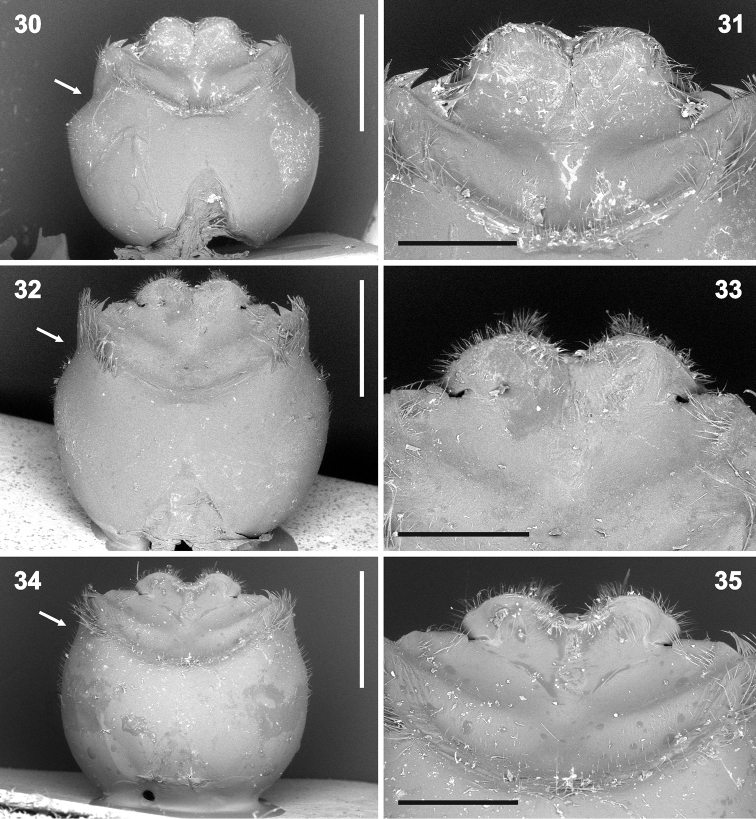
Genital capsule (30, 32, 34 magnification 32×) and detail of hypandrium (31, 33, 35 80×) in ventral view. 30–31Rh.grandicallosagrandicallosa Bergroth, 1911, French Guiana, Camp Caimans 32–35Rh.grandicallosacentroamericana subsp. n.: 32–33 Panama, Pipeline Road 34–35 Costa Rica, Rancho Quemado. Scale bars: 1 mm (30, 32, 34); 0.5 mm (31, 33, 35). (micrographs: P. Kment)